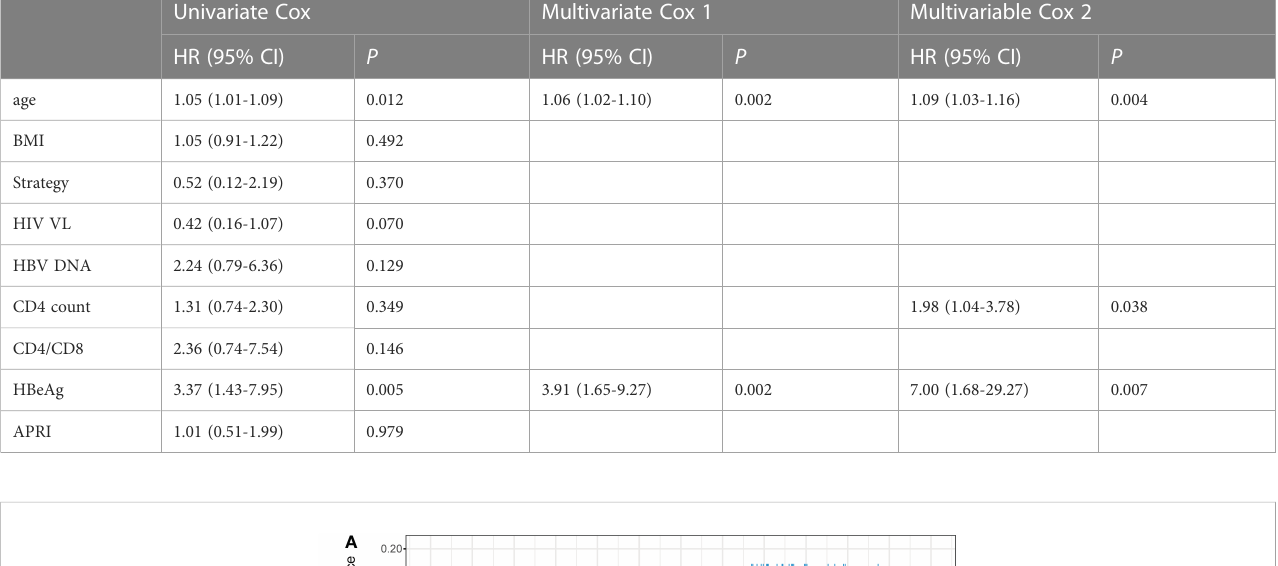
TABLE 3 Association of baseline variables with time to HBsAg clearance in univariate and multivariate Cox regression